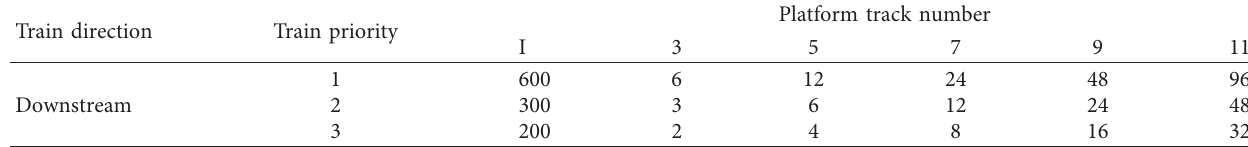
Table 4: Platform track assignment costs for downstream trains with different priorities.